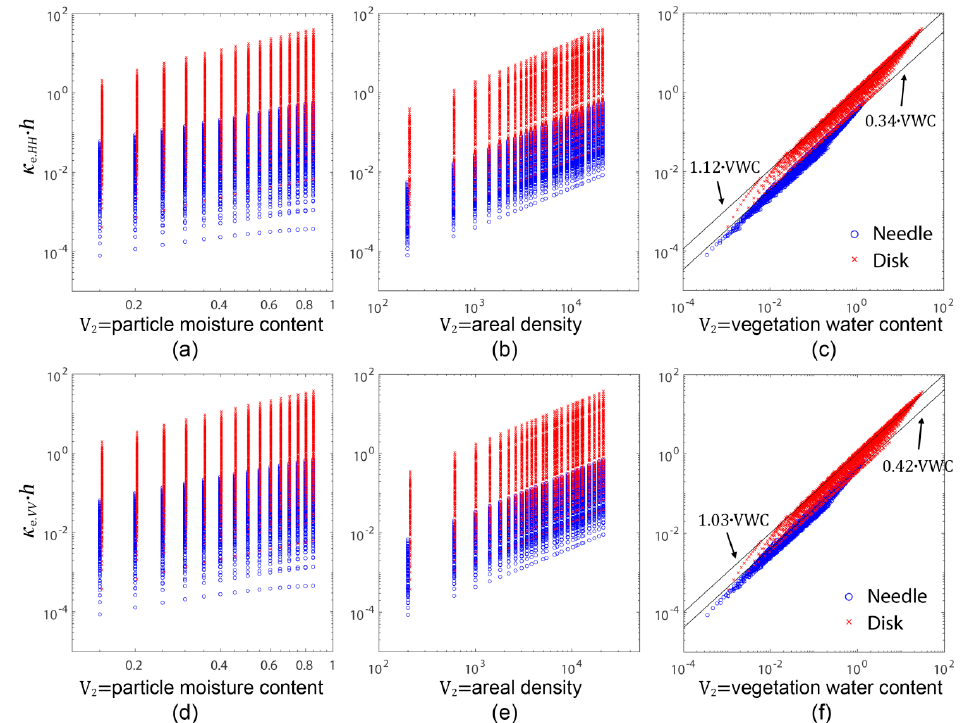
Figure 4. Variations of κ e , pq h in relation to the vegetation descriptors (left: particle moisture content (g/g); middle: the areal density (m − 2 ); right: the vegetation water content (kg/m 2 )) for ( a )–( c ) needle shaped and ( d )–( f ) disk shaped particles.